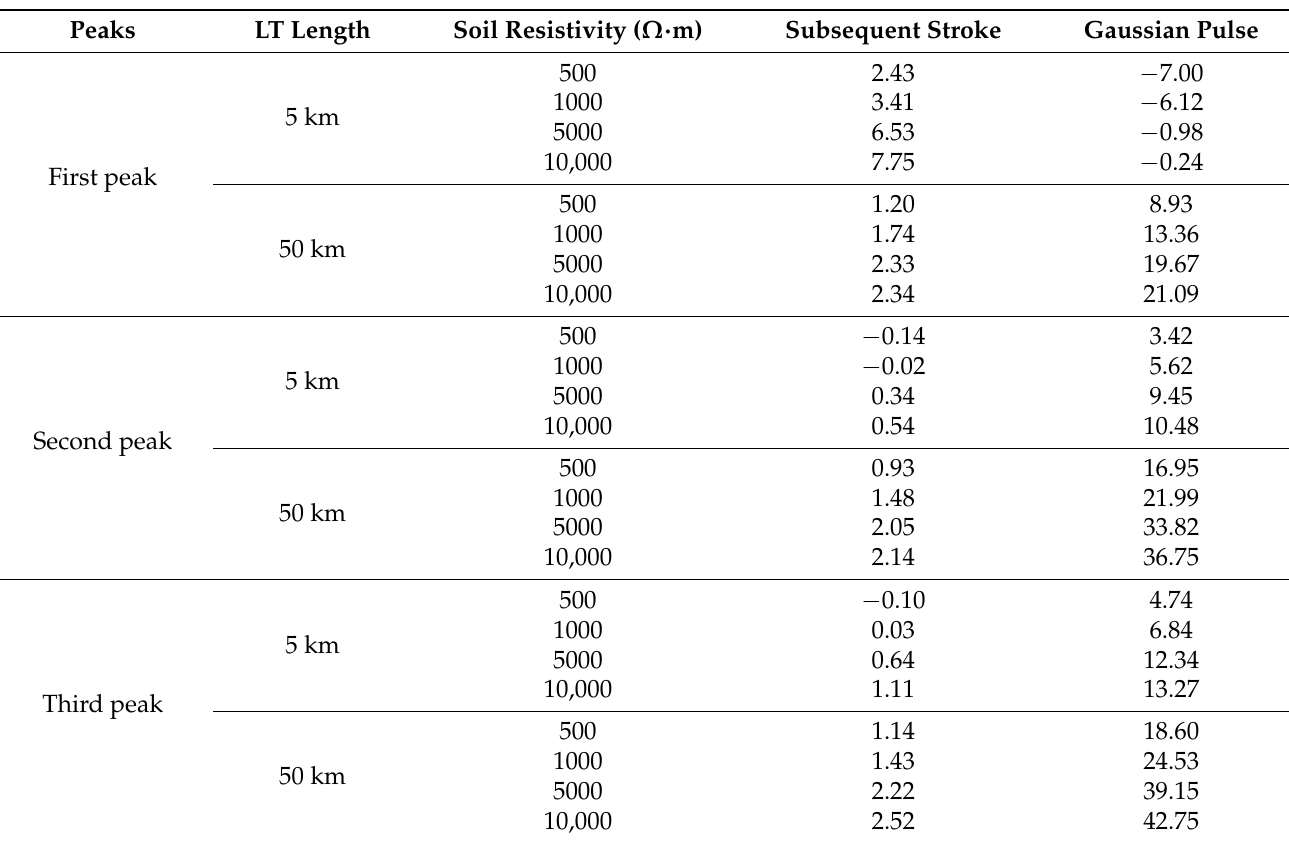
Table 6. Percentage deviation for the transient voltages on the phase-1 generated on the double-circuit line located on the high-resistive